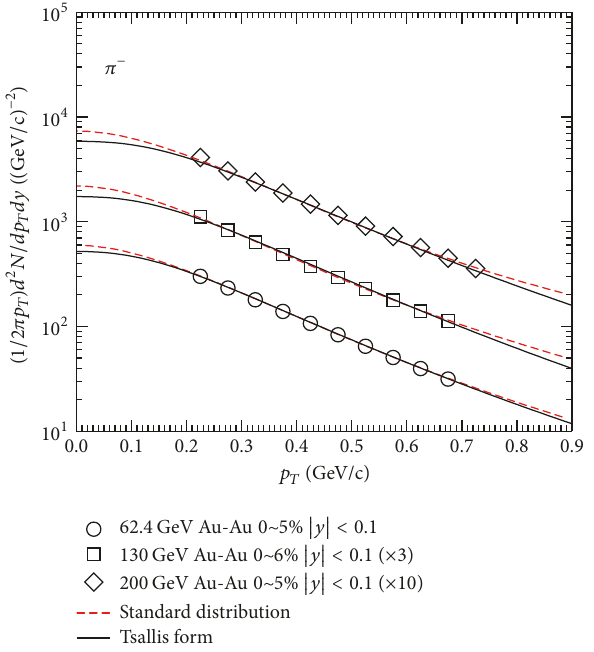
Figure 2: Same as Figure 1, but for √𝑠 𝑁𝑁 = 62.4 (circles), 130 (squares), and 200GeV (rhombuses). The symbols represent the experimental data of the STAR Collaboration with errors being the root quadratic sum of statistical and systematic errors [29].